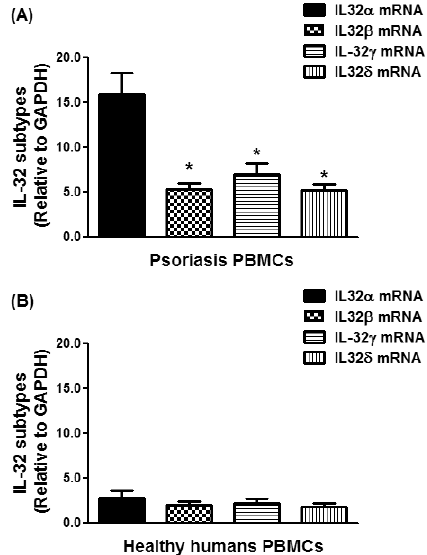
Figure 3. Overexpression of IL-32 α mRNA in the peripheral blood mononuclear cells (PBMCs) of chronic psoriasis patients. ( A ) Gene expression of IL-32 isoforms in PBMCs from psoriasis patients. * p < 0.001 versus IL-32 α mRNA; ( B ) gene expression of IL-32 isoforms in PBMCs from normal human subjects. The mRNAs of IL-32 isoforms were determined by real-time qRT-PCR using either GAPDH or β -actin as an endogenous control in comparative ∆∆ CT method. Results are representative (mean ± SEM) and statistical analysis was performed using one-way ANOVA followed by Tukey’s multiple comparison tests.